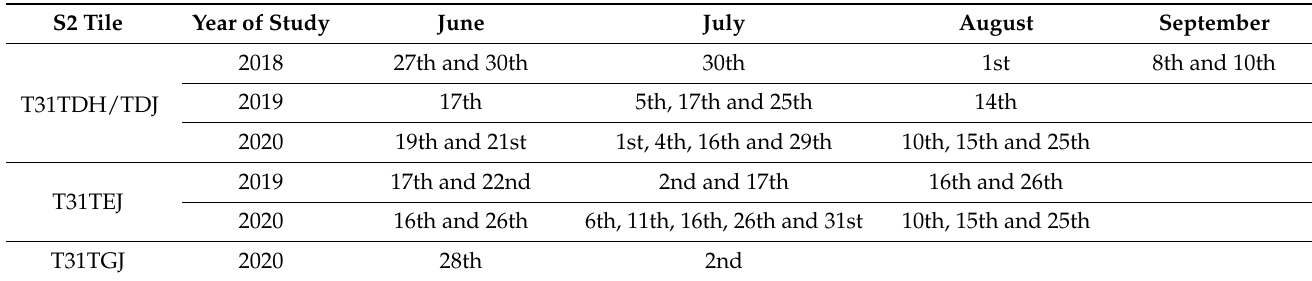
Table 4. Dates of the S2 images used for 2018, 2019 and 2020 for each S2 tile. Images were chosen among all the images available as there is no cloud over the subplots and the date is close to the in field measurements (Maximum difference of 5 days). S2